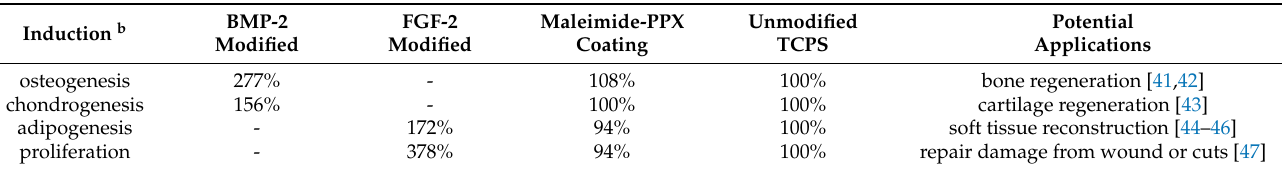
Table 2. Enhanced induction properties of growth factor-modified surfaces based on the maleimide-functionalized poly- p - xylylene (maleimide-PPX) coating a .